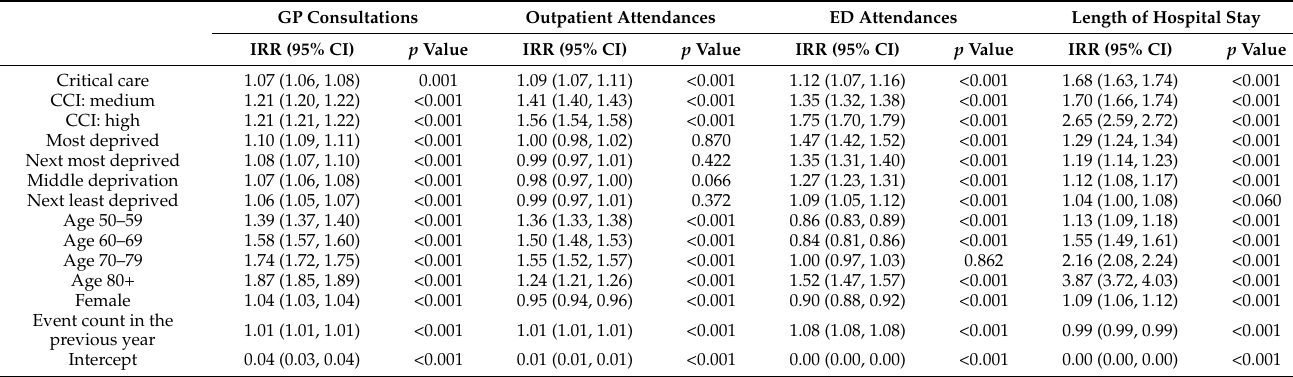
Table 5. Associations between critical care admission and health resource utilisation within 1 year of discharge from